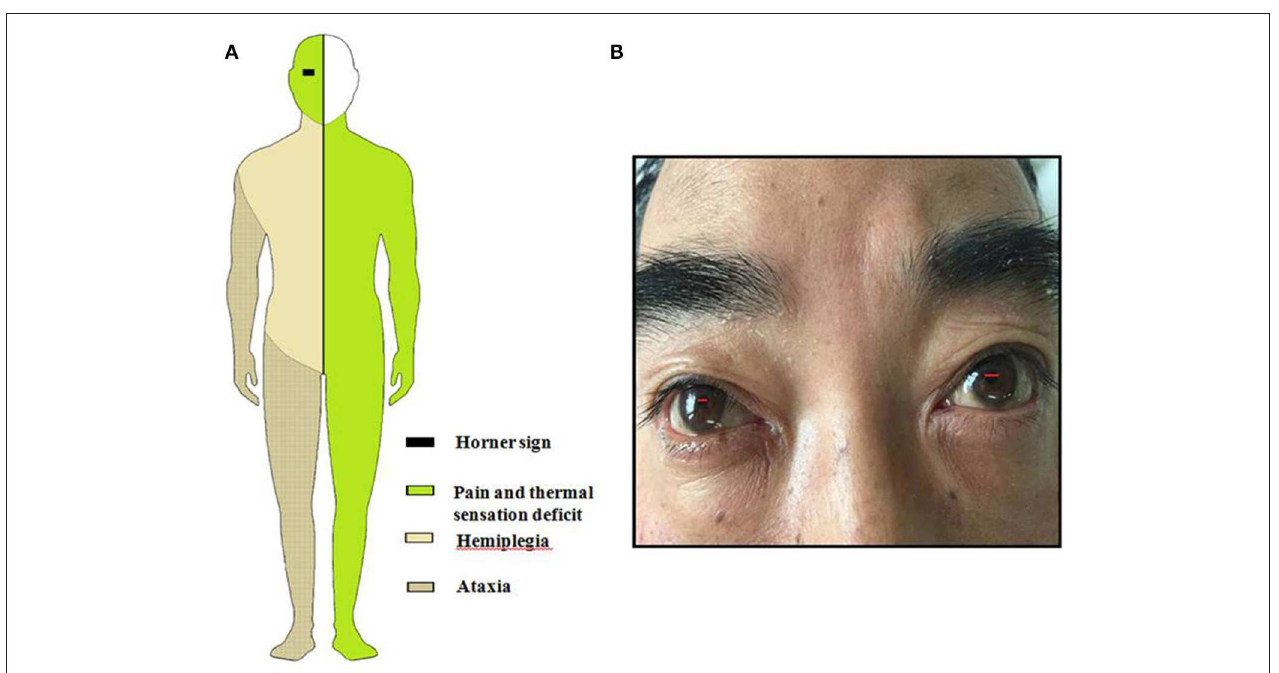
FIGURE 1 | (A) Schematic drawing of Horner sign, pain, and thermal sensory deficit, ataxia and hemiparesis. (B) This figure shows patient’s lacrimation and conjunctival injection in the right eye associated with Horner’s